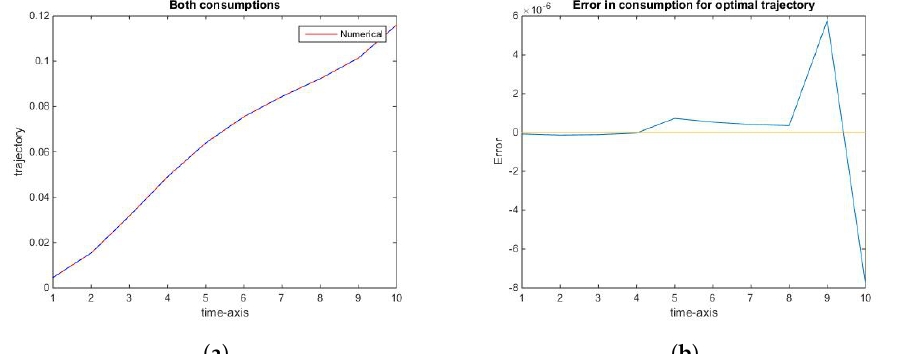
Figure 3. Accuracy of the optimal control trajectory. ( a ): The optimal consumption path, c S ( t , X ( t )) , for the social optimum: numerical (red) and actual (blue dashed); ( b ): The error in the optimal consumption path, c S ( t , X ( t )) , for the social optimum.